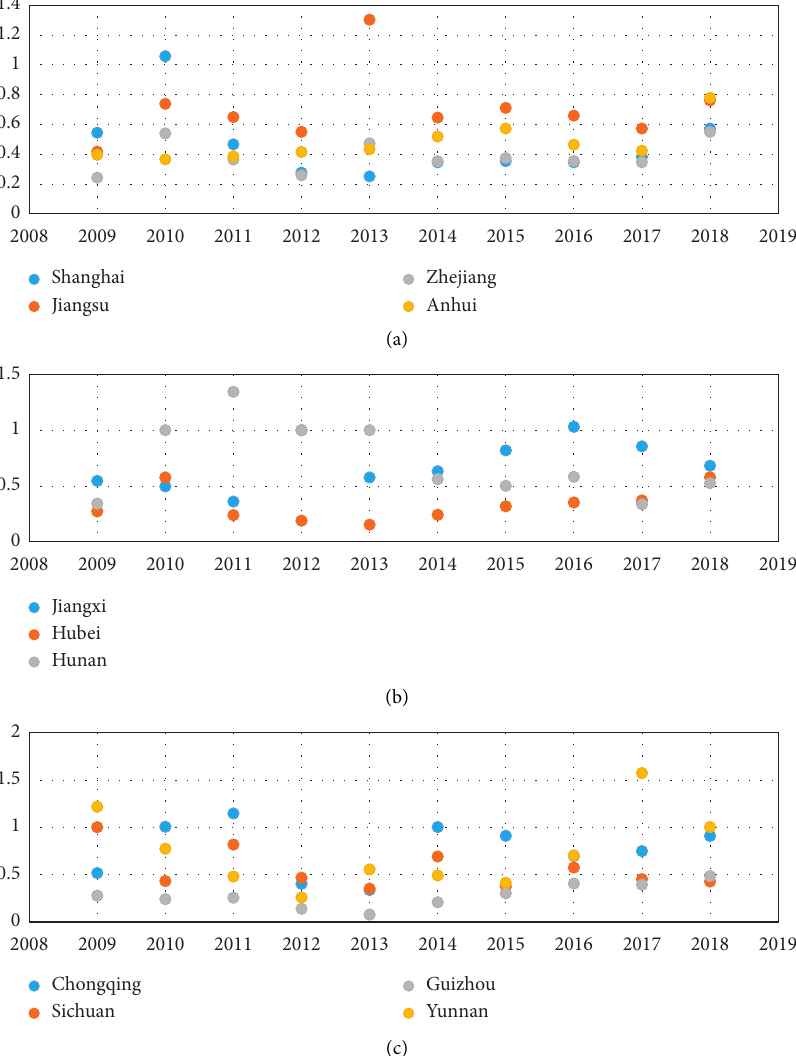
Figure 3: Efficiency of the high-tech industry in the technological innovation stage (2009–2018). (a) Stage1 of Yangtze River Delta. (b) Stage1 of the Middle Region. (c) Stage1 of the Western Region. Source: calculated by National Bureau of Statistics of China (NBSC), Statistical Yearbook of China’s High Technology Industry, Beijing: China Statistics Press,